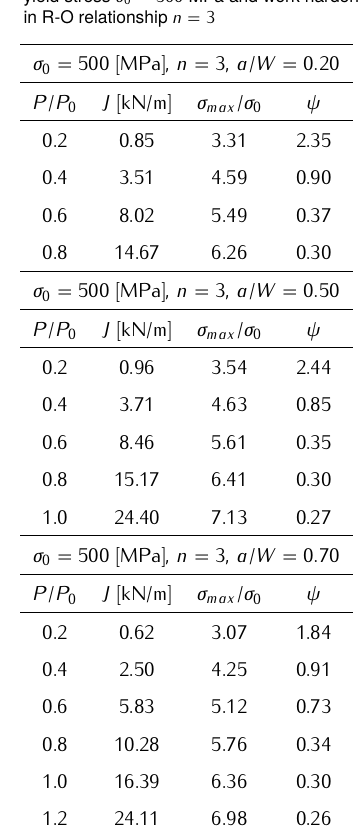
Table B1. Numerical results for CC(T) specimens characterized by yield stress σ MPa and work hardening exponent 0 = 500 in R-O relationship n = 3